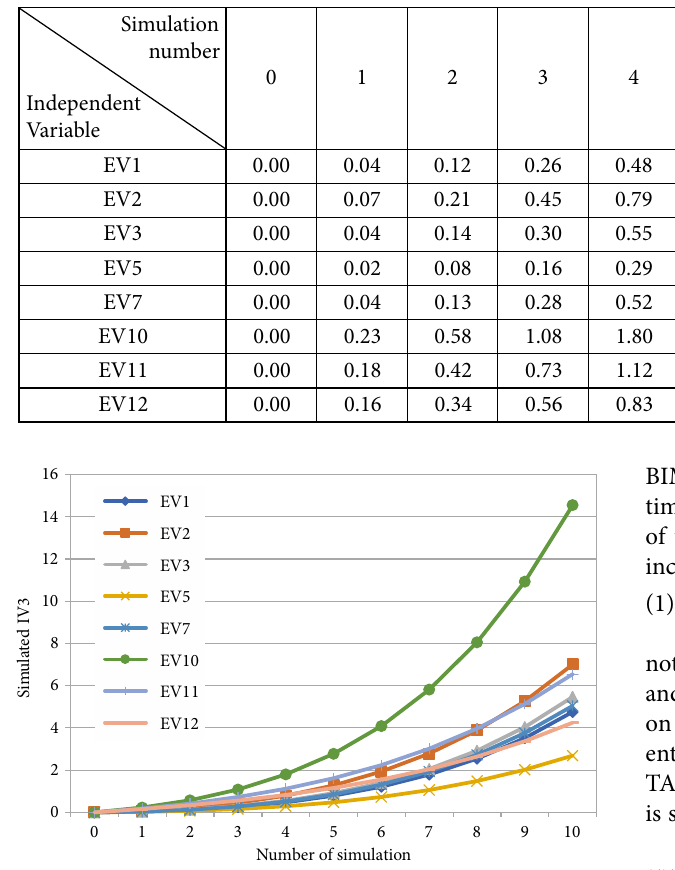
Figure 6. Simulated IV3 by the eight driving